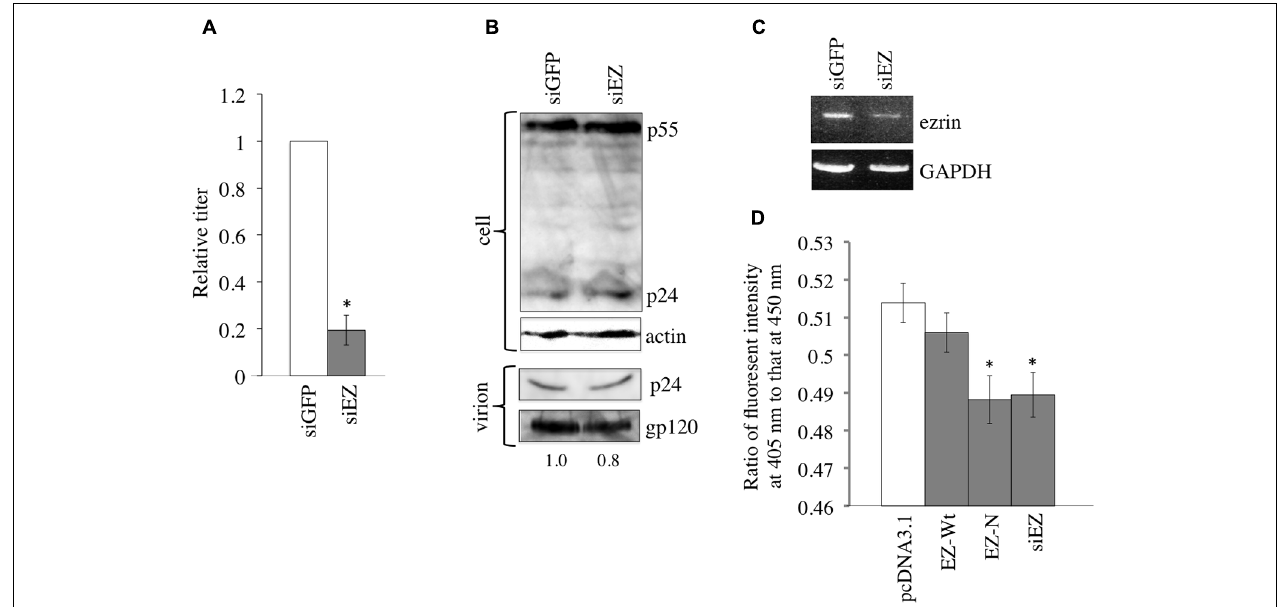
FIGURE 3 | Ezrin is required in HIV-1 vector-producing cells for infectivity of released vector particles. (A) 293T cells were transfected with the HIV-1 vector construct plasmids together with siGFP or siEZ, and culture supernatants from the transfected cells were inoculated onto HeLa/CD4 cells. Transduction titers of siGFP-transfected cells were always set to 1, and relative values of transduction titers are indicated. Error bar shows standard deviations, and an asterisk indicates a statistically significant difference compared to siGFP-transfected cells. (B) Cell lysates (upper panel) and virion pellets of culture supernatants from transfected cells (lower panel) were analyzed by western immunoblotting using the anti-HIV-1 p24 or anti-actin antibody. Intensities of gp120 protein bands were measured, and relative values to gp120 intensity in siGFP-transfected cells were indicated. (C) Semi-quantitative RT-PCR was performed on transfected cells to measure ezrin and GAPDH mRNA levels. (D) Virus-cell fusion activity of indicated HIV-1 vector particles was measured. Ratios of fluorescence intensities at 405 nm to those at 450 nm are indicated. Error bars show standard deviations, and asterisks indicate statistically significant differences compared to the values of pcDNA3.1 HIV-1